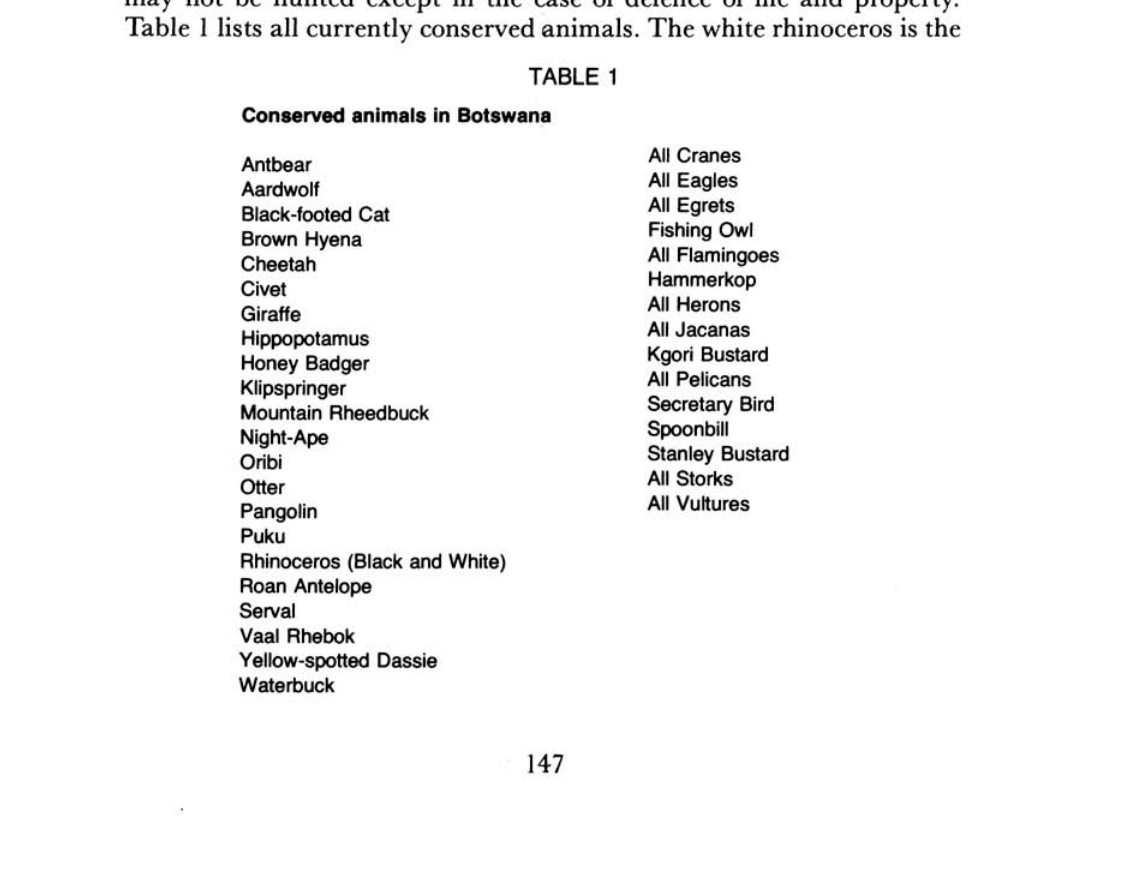
Conserved animals in